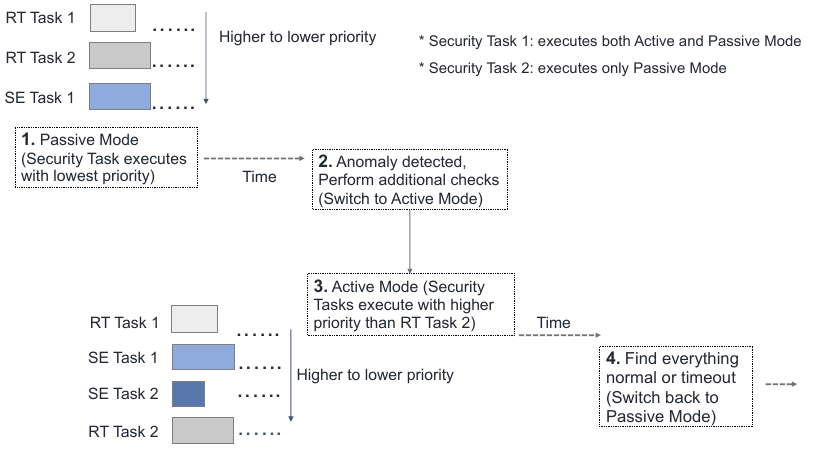
Figure 9. Flow of operations in Contego depicting different modes for the security